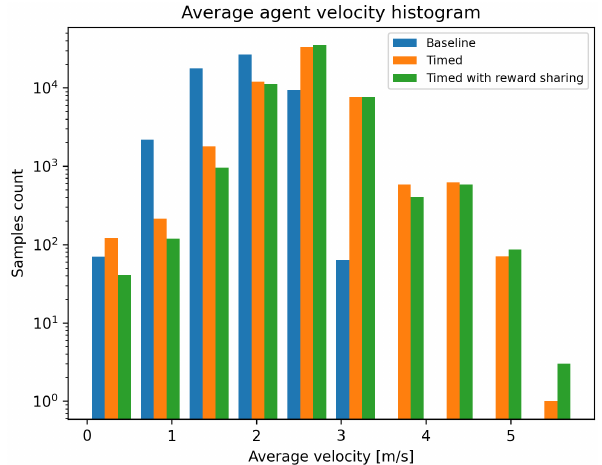
Figure 10. Histogram of the average velocities acquired by the agents (the horizontal axis is loga- rithmic). The reward-sharing mechanism (green) allowed acquiring many more samples with the highest velocities.